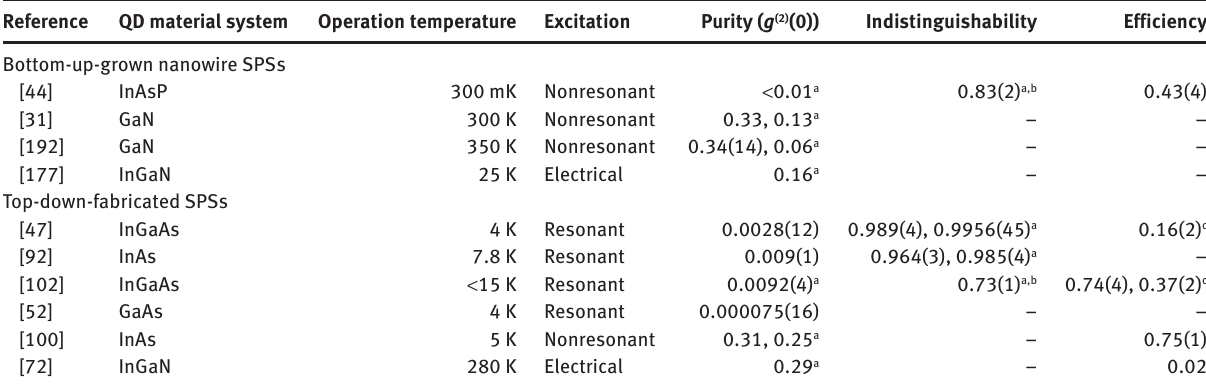
Table 1: Current state-of-the-art SPSs with QDs embedded in bottom-up-grown nanowires and top-down-fabricated structures.